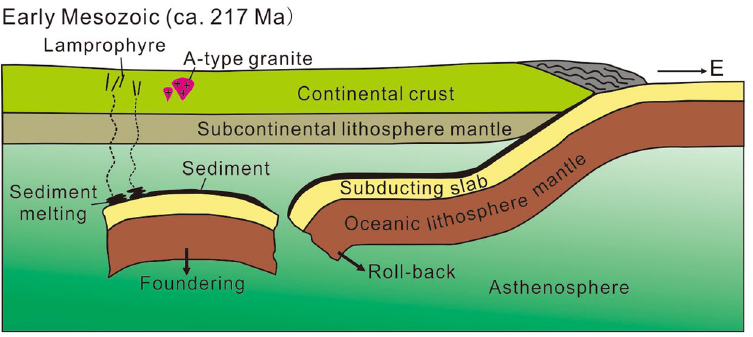
Figure 5. A simplified model showing the magma processes of the Early Mesozoic lamprophyres in Northern Guangxi